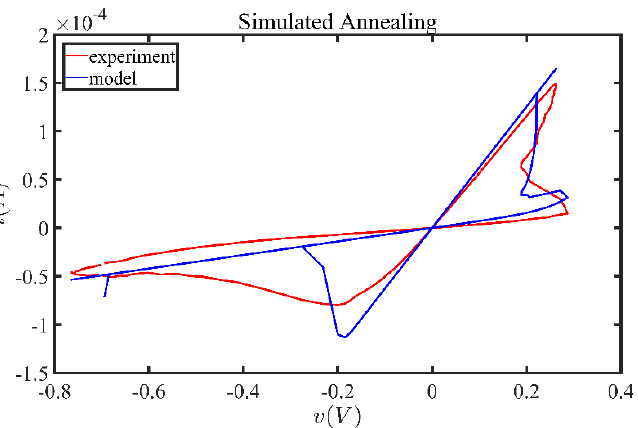
Figure 8. Volt–ampere characteristic curve of memristor. Red is the experimental data, blue is the model fitting data under the optimization algorithm.